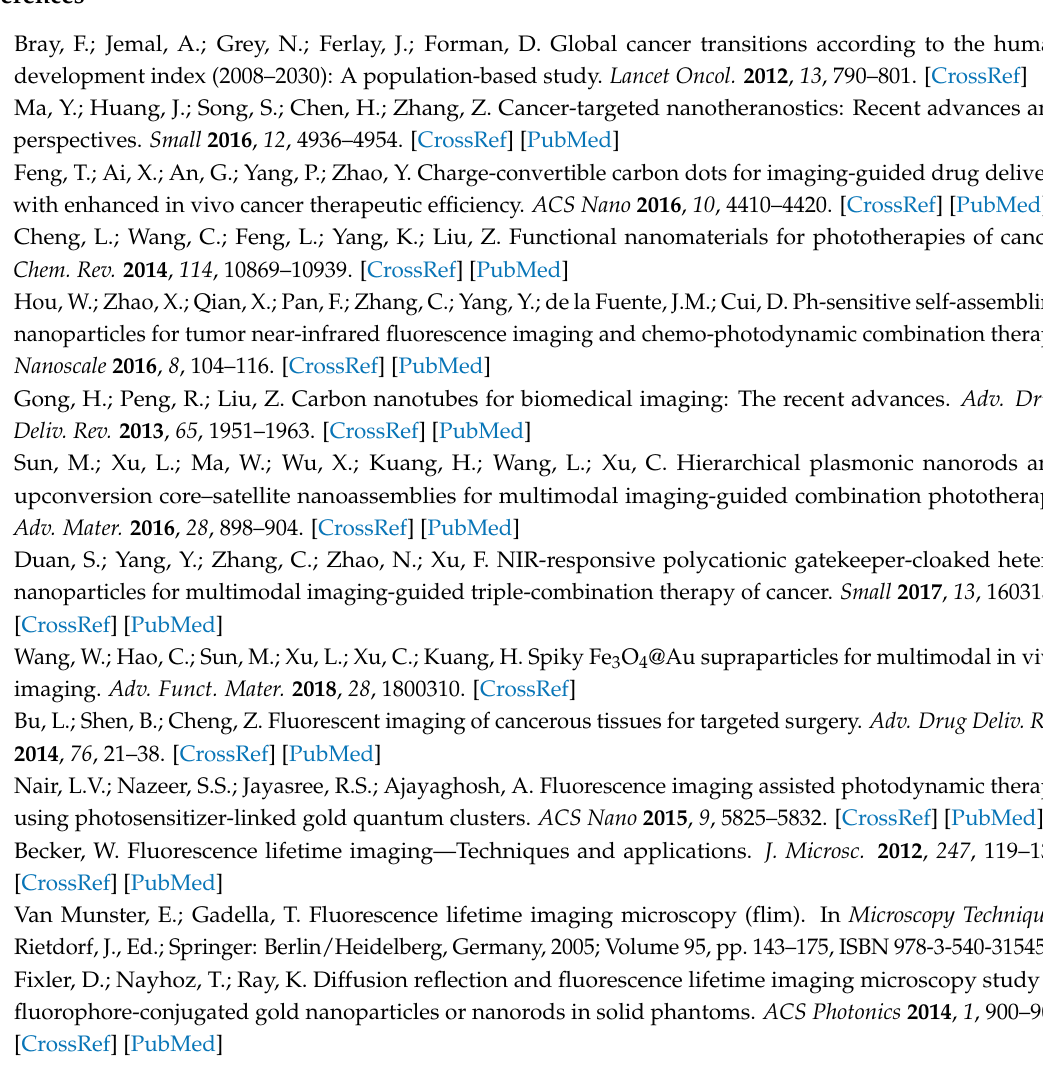
Figure S1: (A) The test curve of Zeta potential: (a) GNR, (b) GNR–PEG 400 , (c) GNR–PEG 600 , (d) GNR–PEG 1000 . (B) The fit curve of Zeta potential of (a), (b), (c), (d); Figure S2: UV-vis spectra of GNR and GNR–PEG (molecular weights of PEG are 400, 600 and 1000, respectively); Figure S3: Histograms and Gaussian fittings of particle size distribution of the CDs; Figure S4: UV-vis spectra of GNR, GNR-PEG 1000 and GNR-PEG-CDs; Figure S5: TEM of the hybrid (100 µ g mL − 1 ) after irradiation (a) and ultrasonic (b) for 10